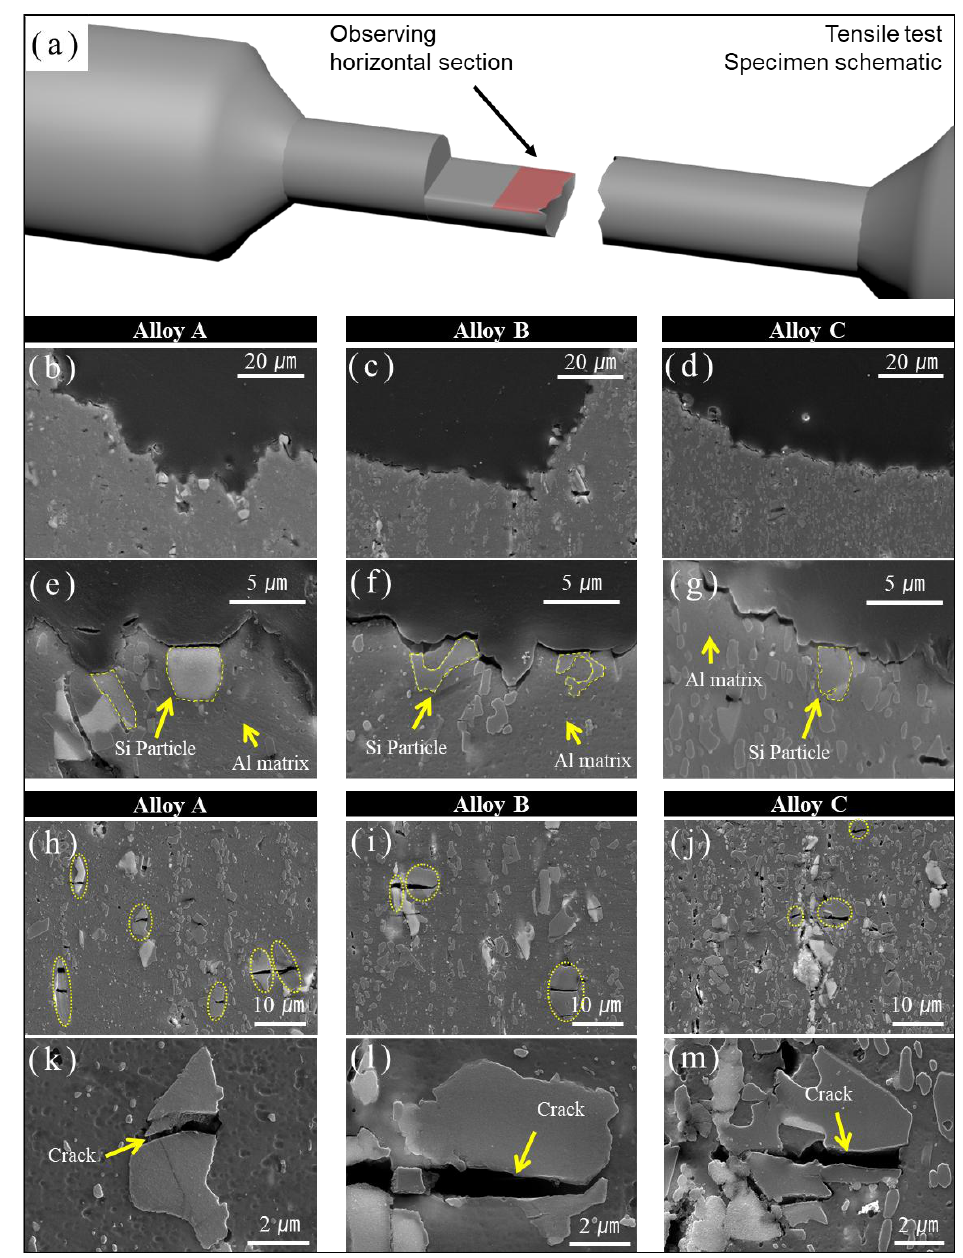
Figure 5. ( a ) Schematic diagram of the fracture mechanism in the tensile test of specimens of Al-XSi-3Cu-0.6Mg-0.5Fe [X = 10, 12.6, 14] extruded alloy; ( b – d ) show low-magnification images and ( e – g ) show high-magnification images of the fracture surface at the boundary of the specimens; ( h – j ) show low-magnification images and ( k – m ) show high-magnification images of the fracture surface at the center of the specimens.